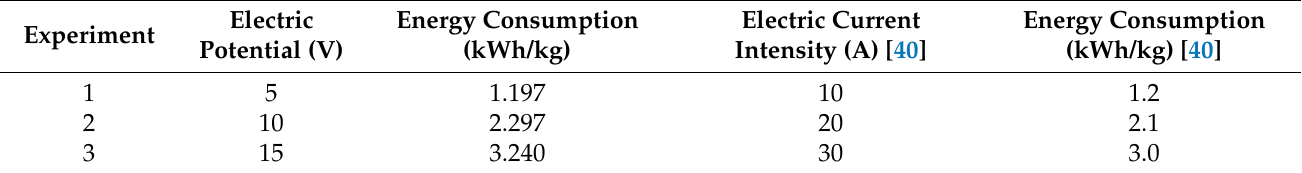
Table 8. Comparative data of Energy consumption